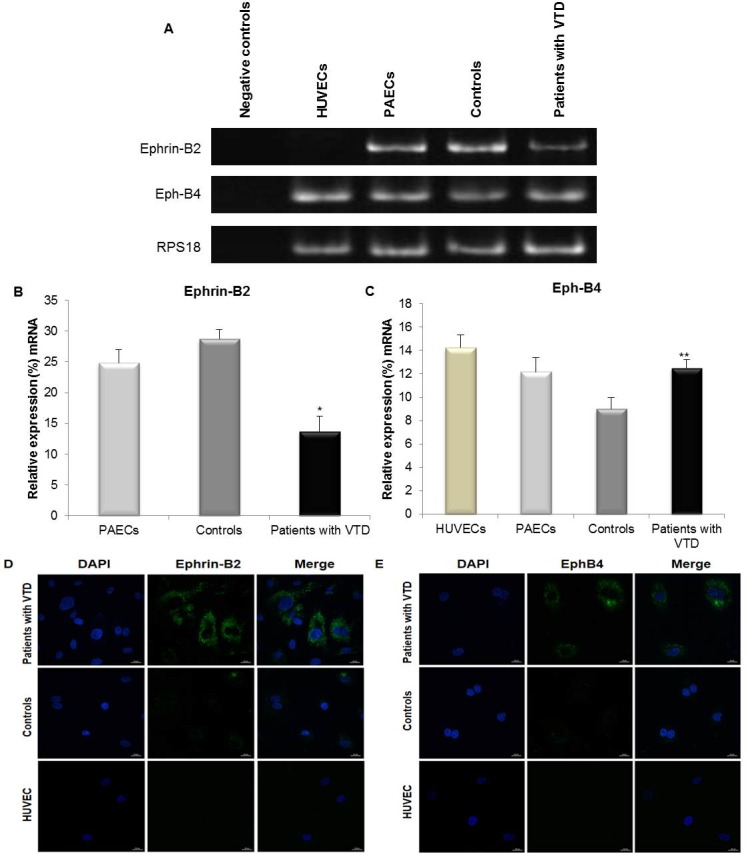
Relative expression of ephrin-B2 and Eph-B4 genes in ECFC-ECs from peripheral blood of controls and patients with VTD.(A) mRNA expression of ephrin-B2 (639 bp), Eph-B4 (251 bp) and RPS18 (240 bp) as housekeeping gene in peripheral blood samples from controls and from patients with VTD. (B) Densitometric analysis of ephrin-B2 and (C) Eph-B4 evaluated in positive controls (HUVECs and PAECs) in ECFC-ECs of controls and patients with VTD. Results are expressed as mean ± standard deviation of three independent experiments in passage 4. *P = 0.017, **P = 0.01. Expression of the proteins Ephrin-B2 (D) and Eph-B4 (E), was evaluated by confocal inmunofluorescence microscopy.